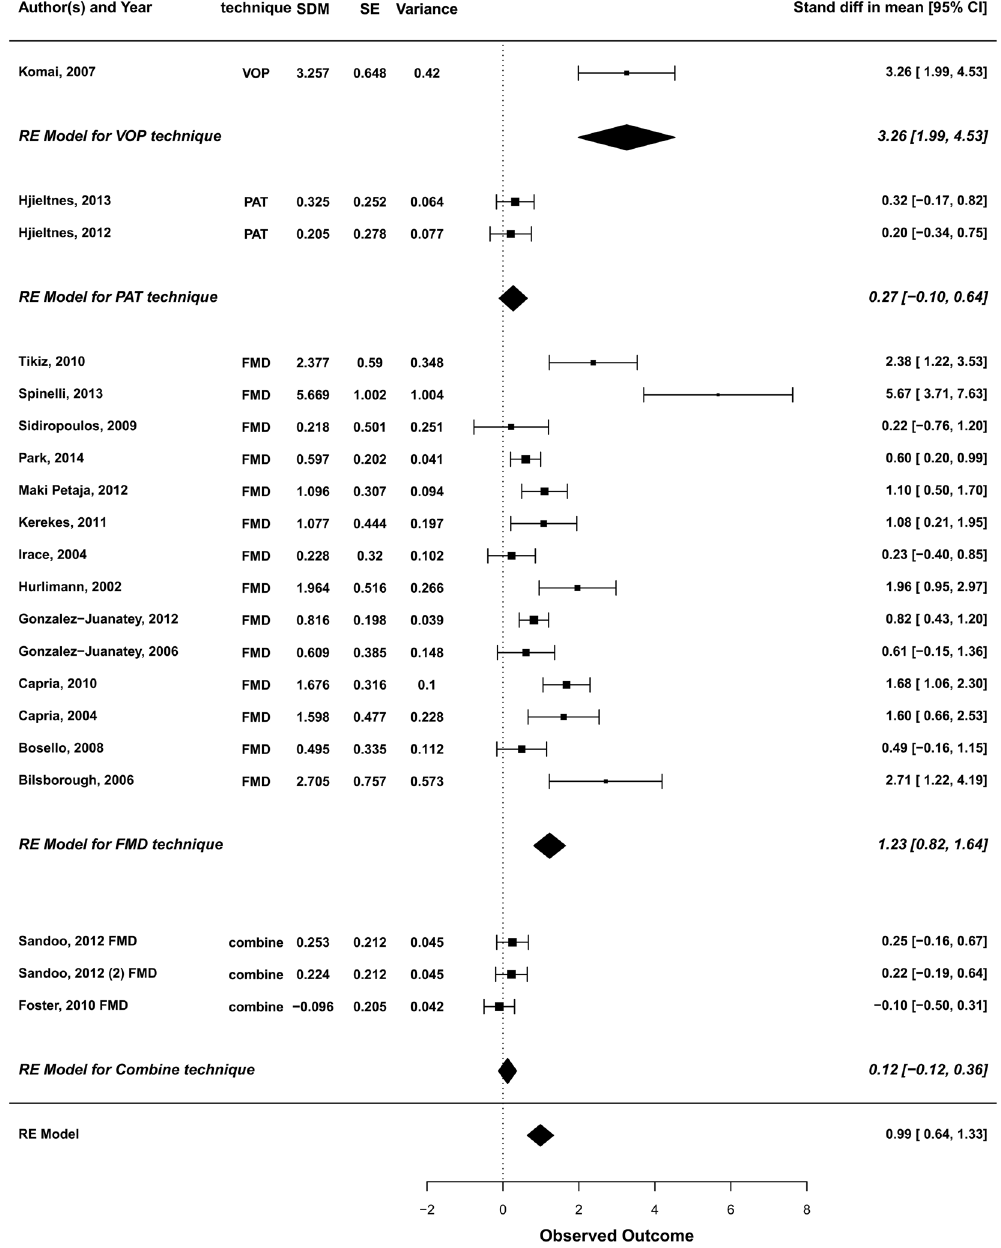
Figure 3. Subgroup analysis. A subgroup analysis was performed after stratification for technique used to assess endothelial function. Overall estimates for each subgroup were computed. SDM, standardised difference in means; SE, standard error; CI, confidence interval; FMD, flow mediated dilatation; PAT, peripheral arterial tonometry; VOP, venous occlusion plethysmography; RE,